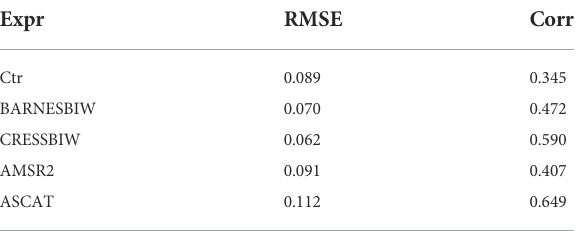
TABLE 3 Comparison of SMAP with Ctr, BARNESBIW, CRESSBIW, ASCAT, and